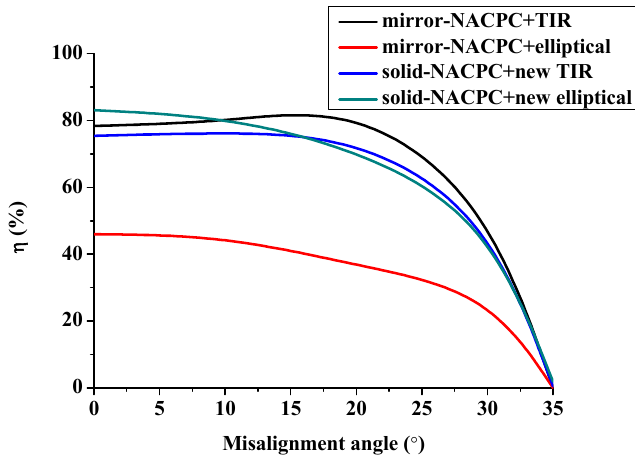
Figure 23. The optical e ffi ciency of the misalignment light-guiding Figure 24. The optical efficiency of the misalignment light-guiding units.